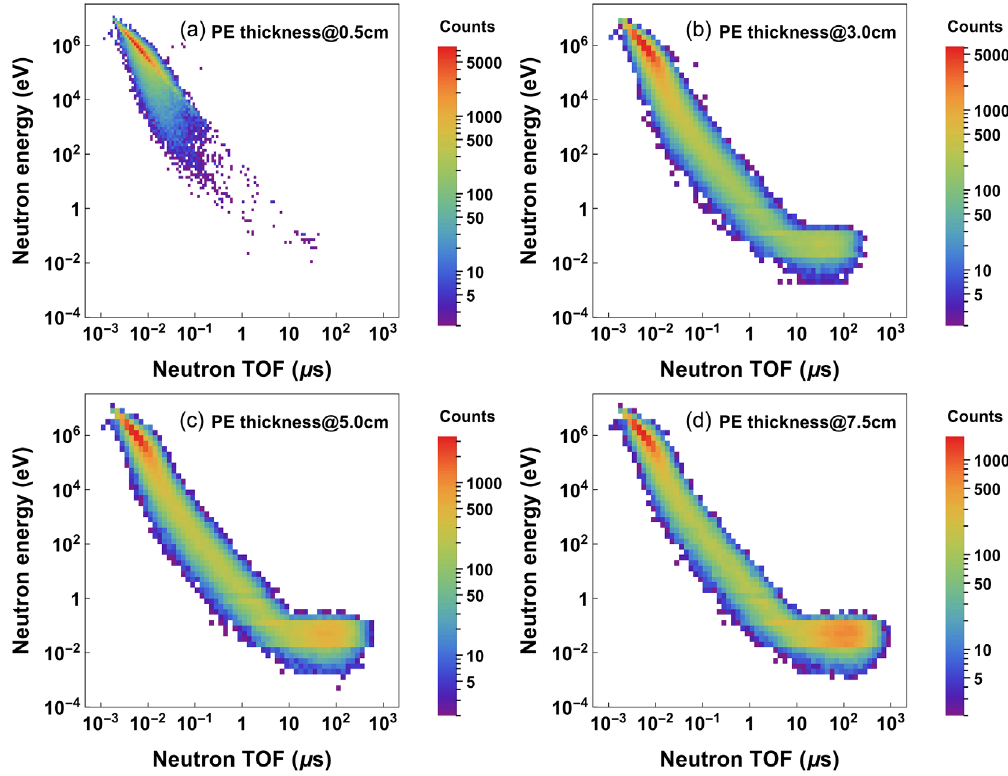
FIG. 30. The number of neutrons arriving in the BF 3 monitor plotted versus the neutron TOF and energy in a 2D histogram. The amount of lost protons is 10 11